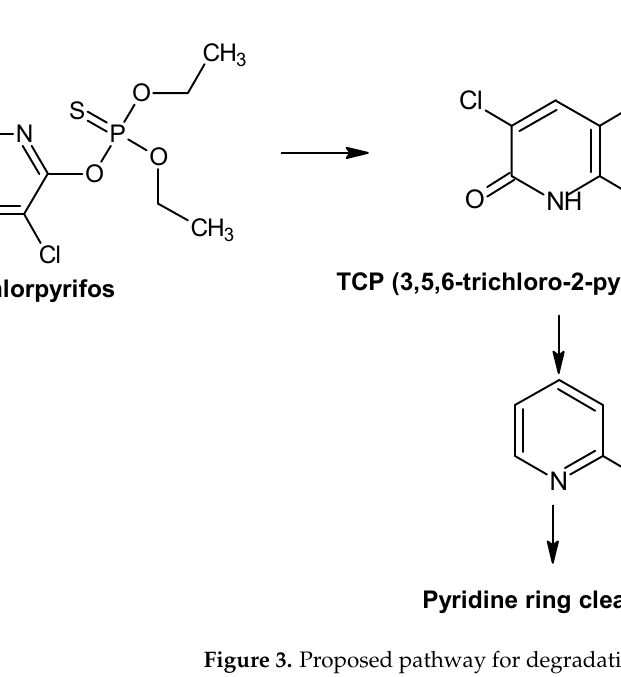
Figure 2. Possible fate of pesticides in the environment [78,225].